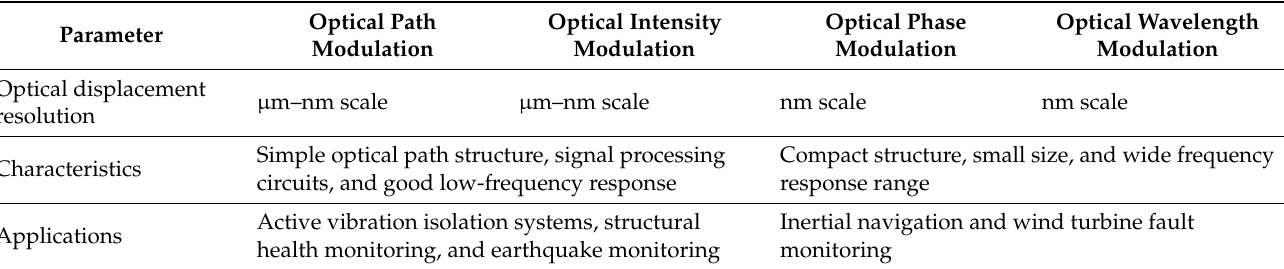
Table 5. Parameters of the four types of optical